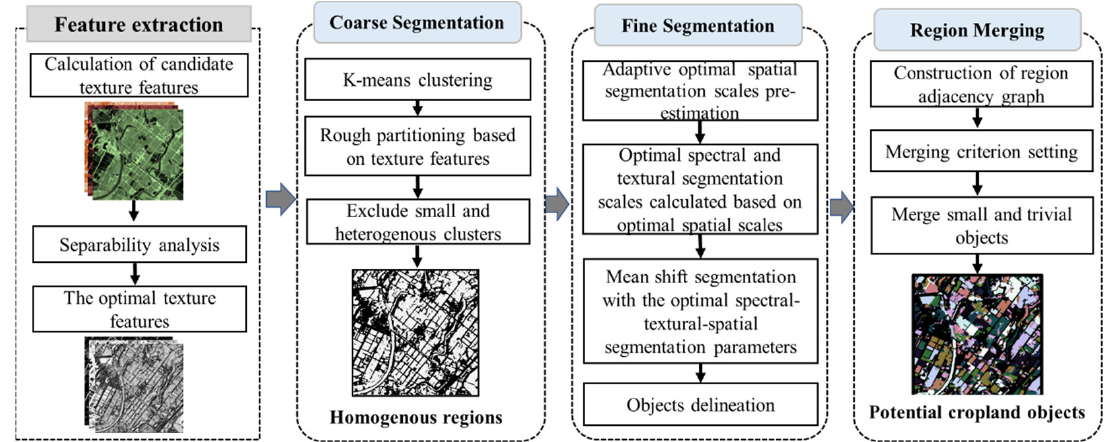
Figure 4. The workflow of extracting potential cropland parcels based on the MSAOS.